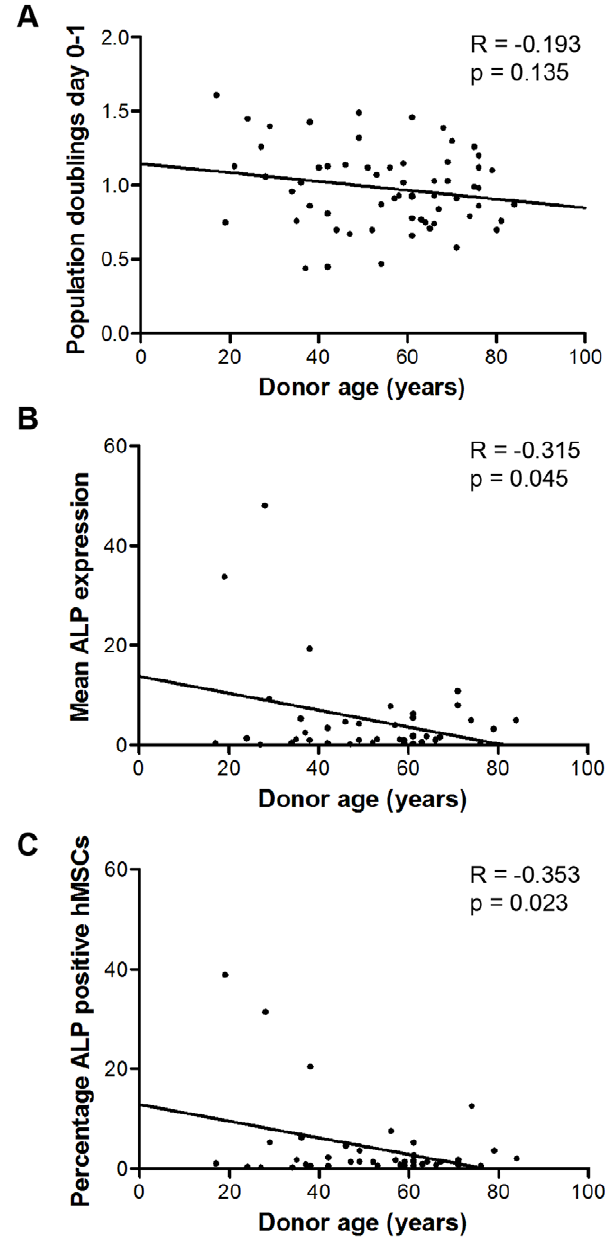
Figure 2. Correlation between biological parameters and donor age. A correlation between age and clinical and biological labels could not be determined for labels such as A) population doublings per day between day 0–1 and bone formation. Correlation with donor age could solely be determined for B) the mean ALP expression and C) the percentage ALP positive cells in basic medium.